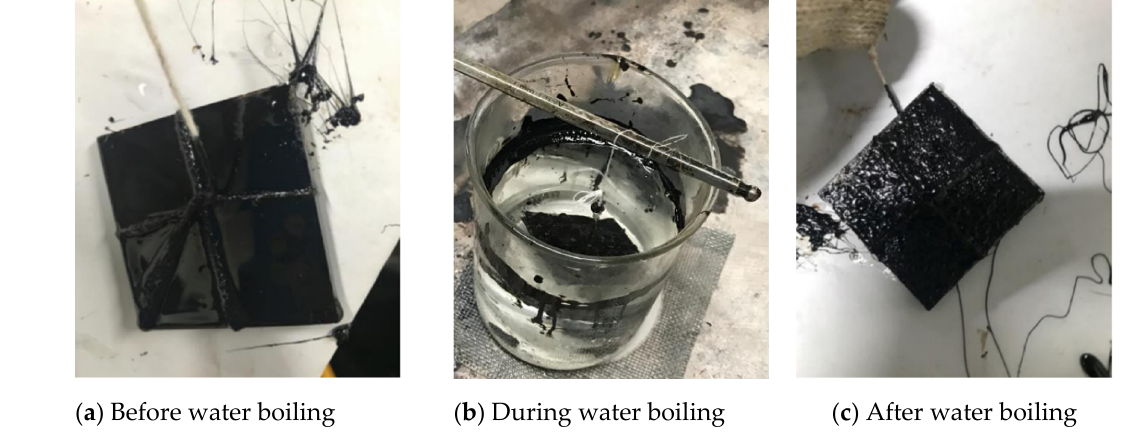
Figure 15. Test pictures of glass aggregate.